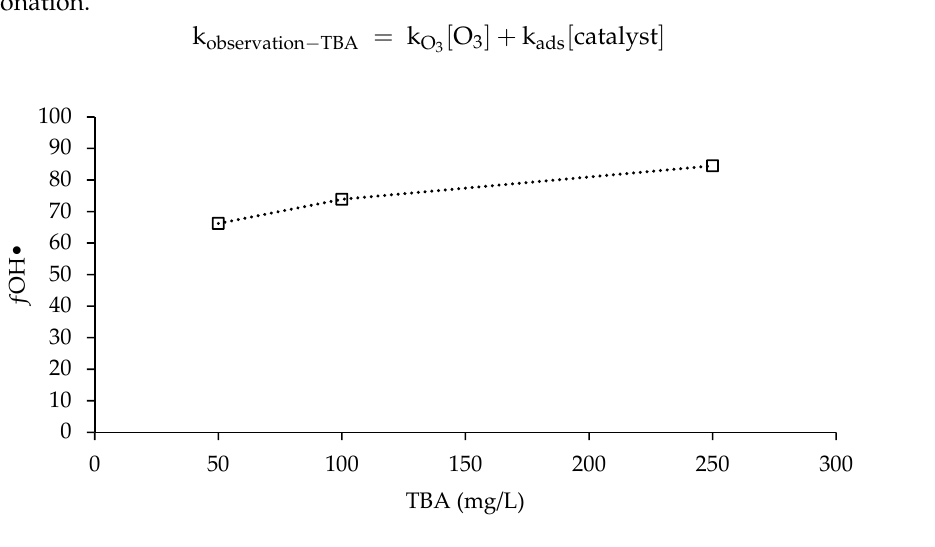
Figure 15. Effect of TBA on a hydroxyl radical fraction.